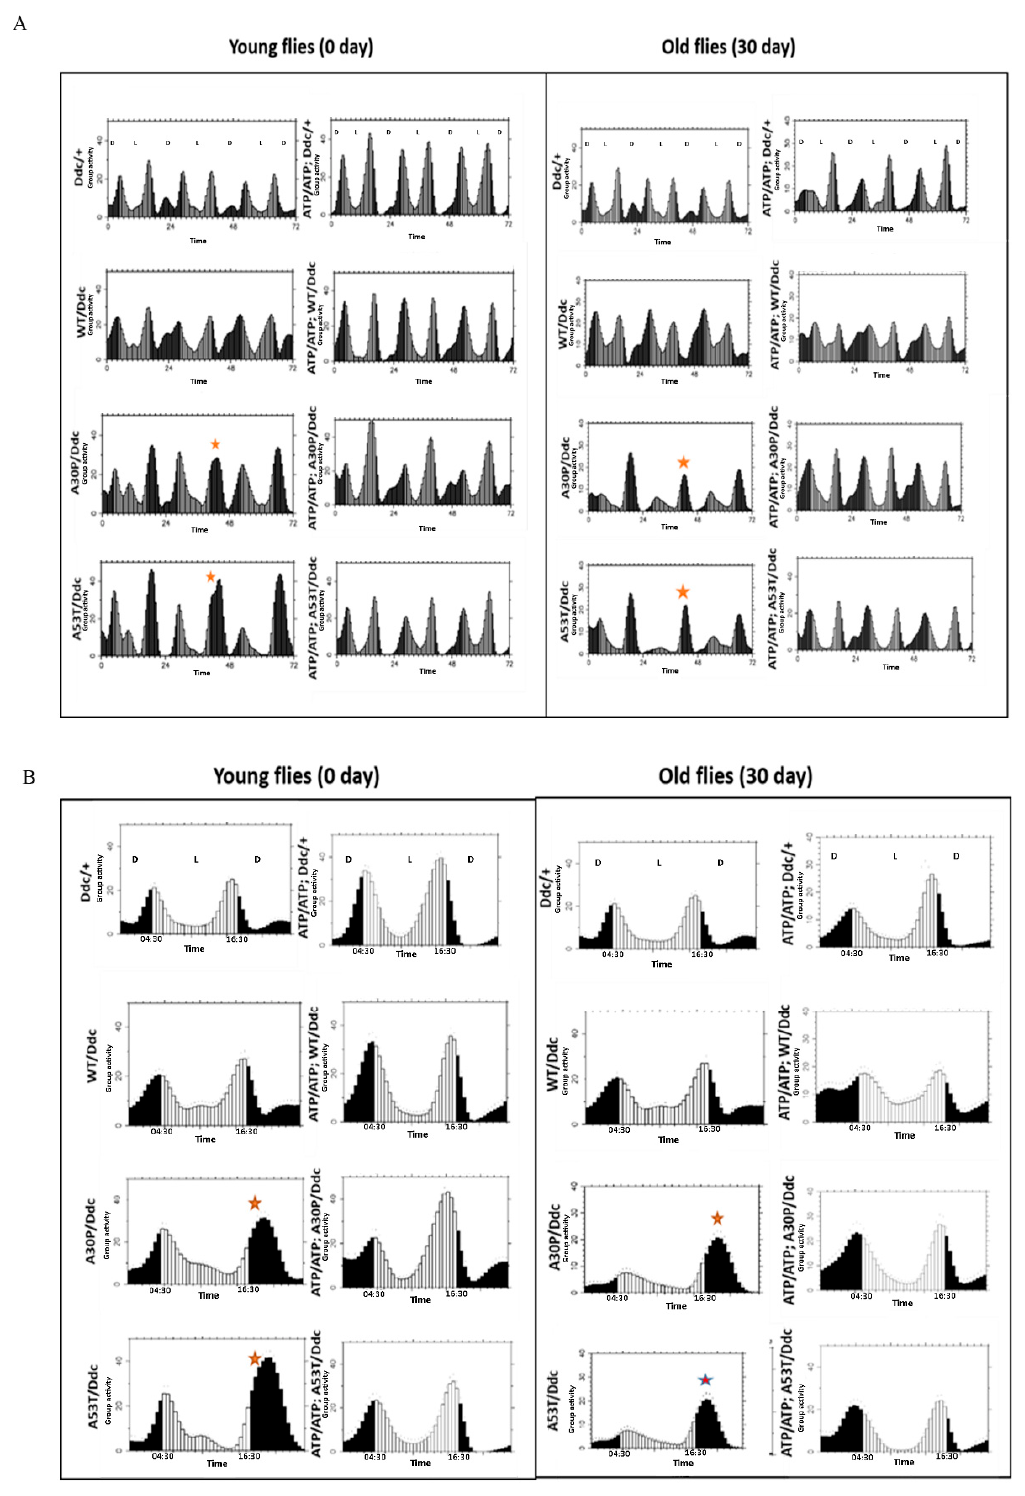
Figure 7. ATP13A2 silencing alters the circadian defect of flies expressing mutant α -syn. Locomotor activity and anticipation of the dark–light transition of young (0–3-day-old) and old (30-day-old) flies expressing WT, A30P, and A53T α -syn with and without ATP13A2 silencing were studied using a Drosophila activity monitor (DAM) ( A ) and the corresponding Eduction graph is presented ( B ). Dark (12 h) and light (12 h) phases were indicated as D and L, respectively. Group activity (counts/min) was also shown. A30P and A53T flies (young and old) showed defective evening light expectancy, as indicated by * ( A , B ).